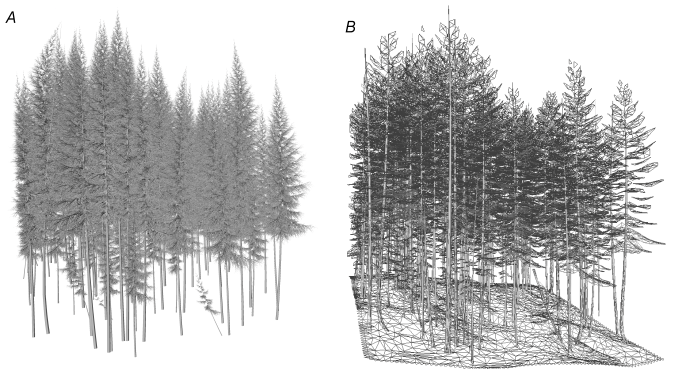
Figure 2. ( A ) Forest plot reconstructions representing individual stems; and ( B ) a coarser level of detail, where foliage clustered around branches is represented as planar polygons.